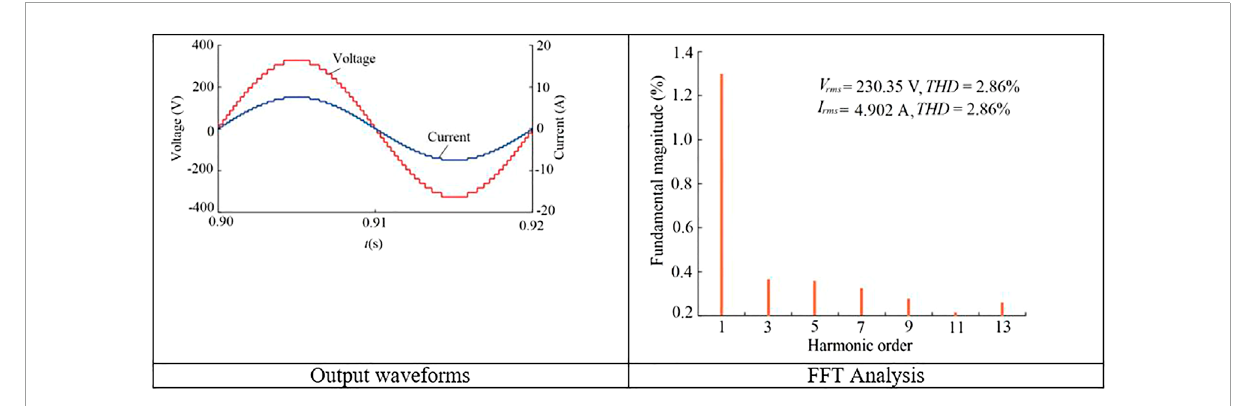
FIGURE 4 Operation beneath full load operation.